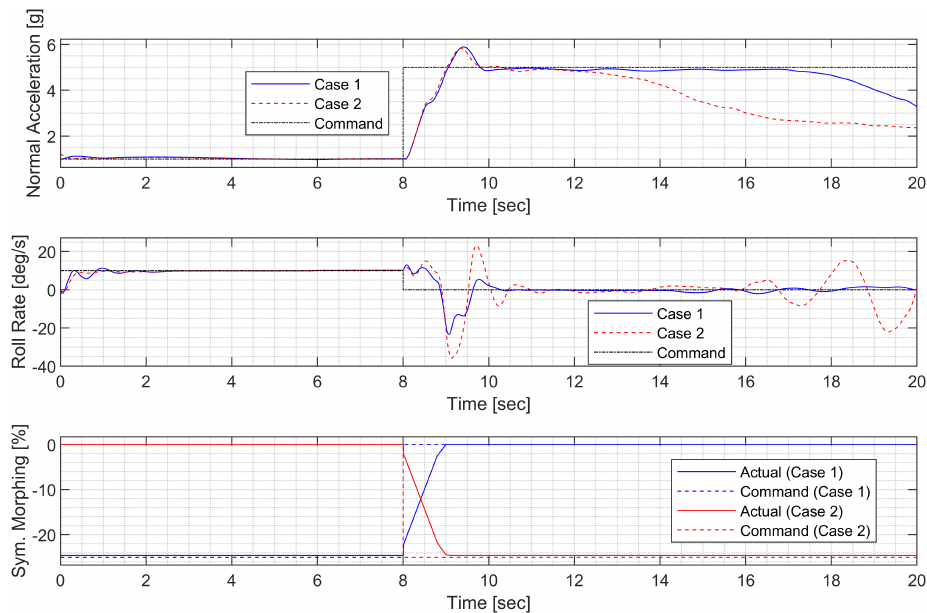
Figure 17. Controlled states and symmetric morphing parameter history for the high-g turn ( H ∞